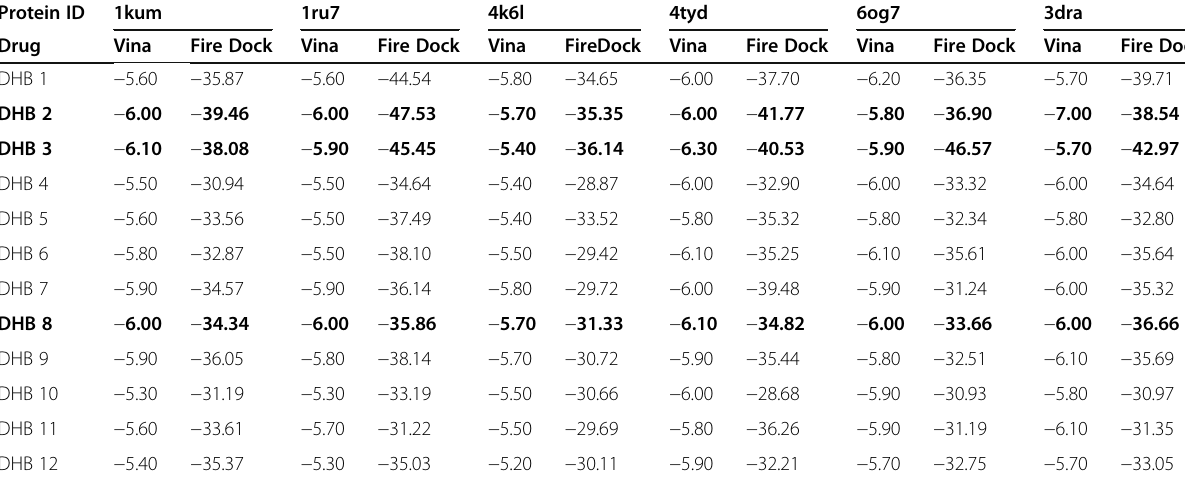
Table 3 Molecular docking scores for DHB Protein